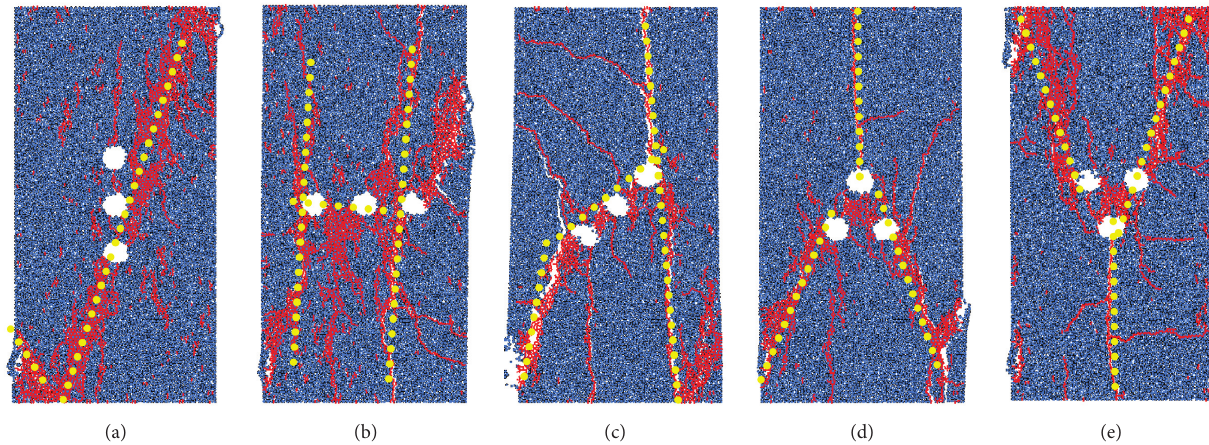
Figure 23: Failure modes of samples with different boreholes arrangement forms. The arrangement forms of (a), (b), (c), (d), and (e) are vertical layout, horizontal layout, inclined layout, up three-flower layout, and down three-flower layout,